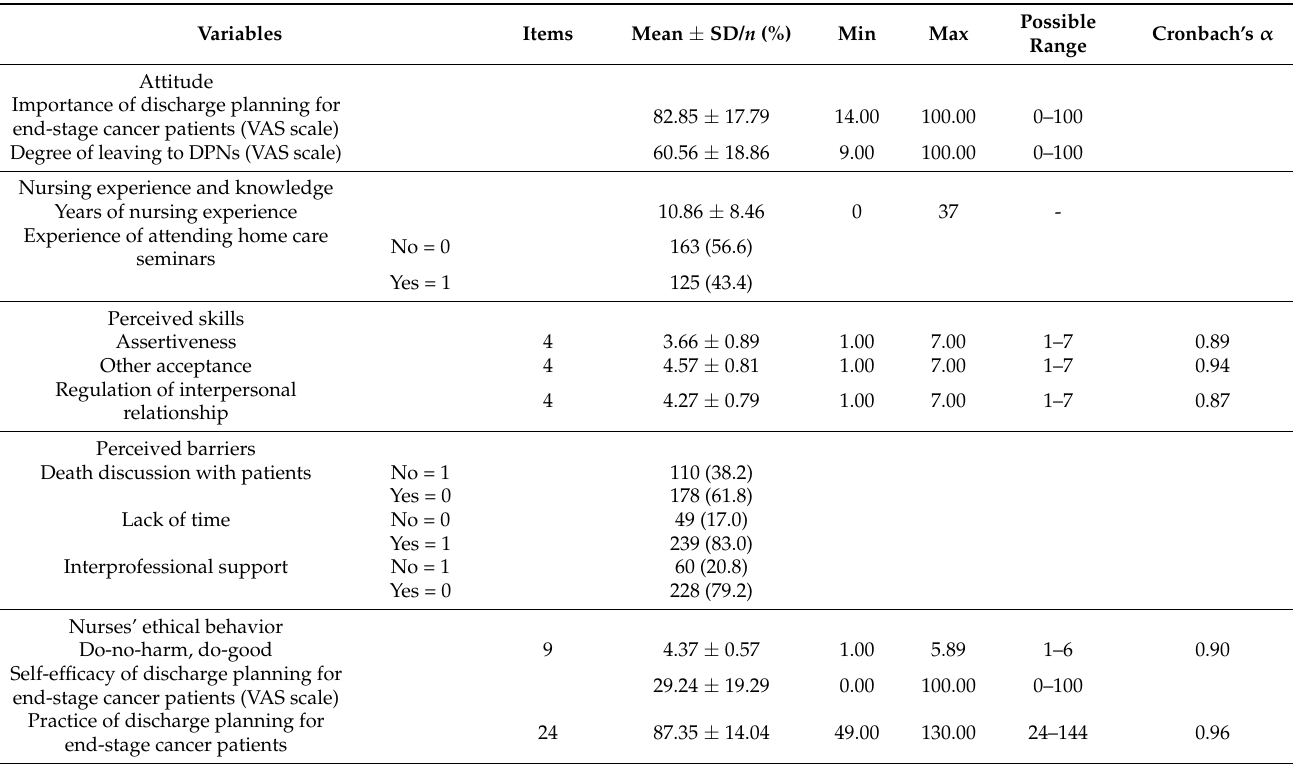
Table 2. Results of description statistics (N =